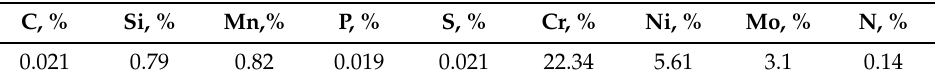
Table 1. The chemical composition of Duplex X2CrNiMoN22-5-3 stainless steel, wt